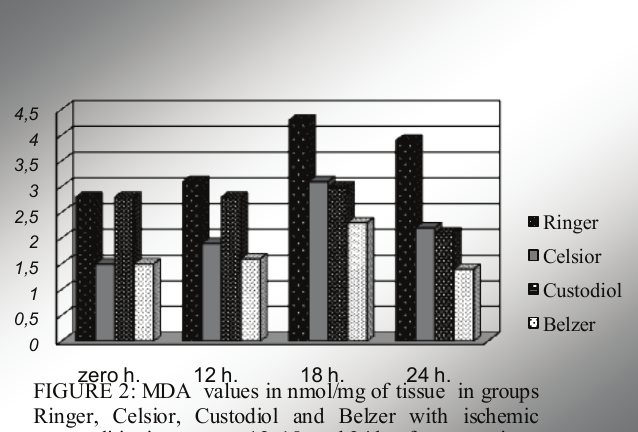
FIGURE 2: MDA values in nmol/mg of tissue in groups Ringer, Celsior, Custodiol and Belzer with ischemic preconditioningat zero, 12, 18, and 24h. of preservation